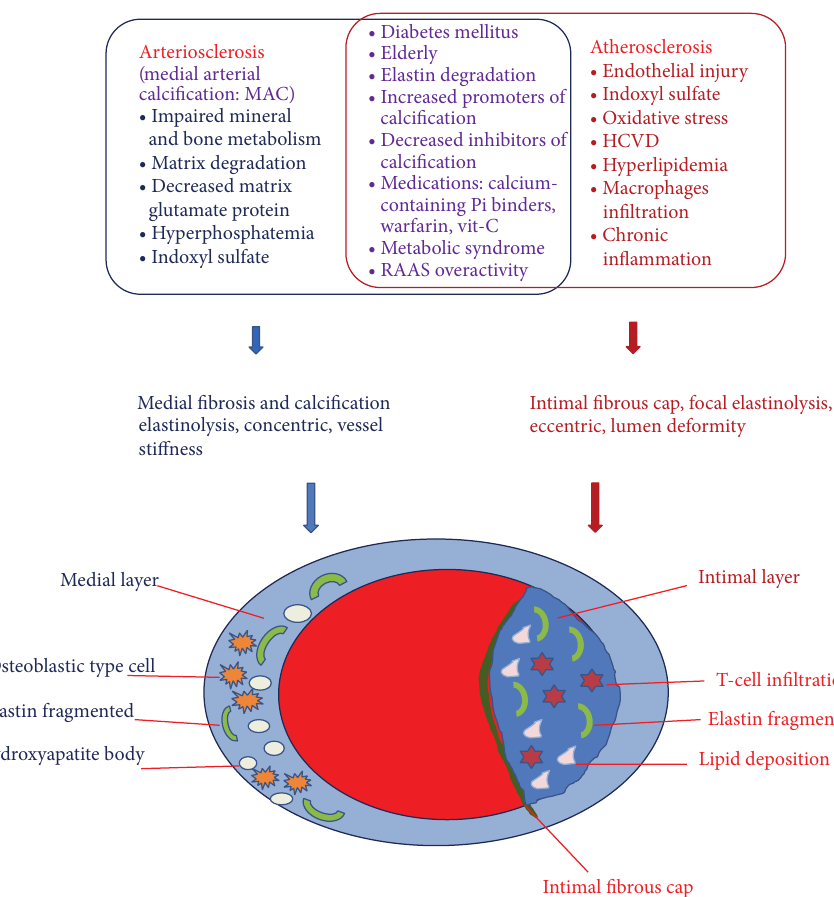
Figure 2: Risk factors associated with medial arterial calcification (MAC) versus atherosclerosis in CKD (above). Simplified histopathology pictures of the MAC and atherosclerotic calcification (below). Disordered mineral metabolism in CKD with its associated characteristics of hyperphosphatemia, hypercalcemia, and renal osteodystrophy, as well as vitamin D perturbation and klotho deficiency, increases the risk for MAC. Oxidative stress and chronic inflammation in uremia also accelerate atherosclerosis. A number of risk factors can drive both pathologies. Both atherosclerotic calcification and medial calcification stiffen arterial conduit vessels, impairing heart function. The eccentric remodeling of atherosclerotic calcification also reduces lumen diameter and predisposes to acute